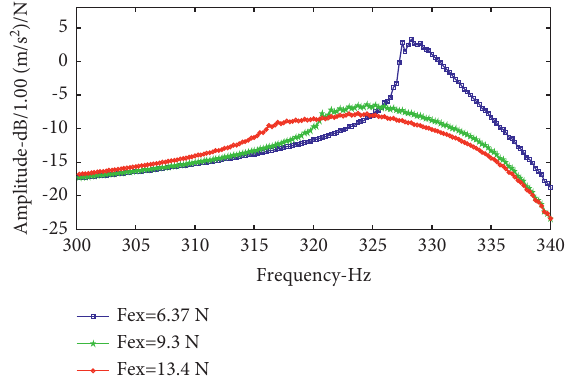
Figure 13: Frequency response function at different excitation force levels.